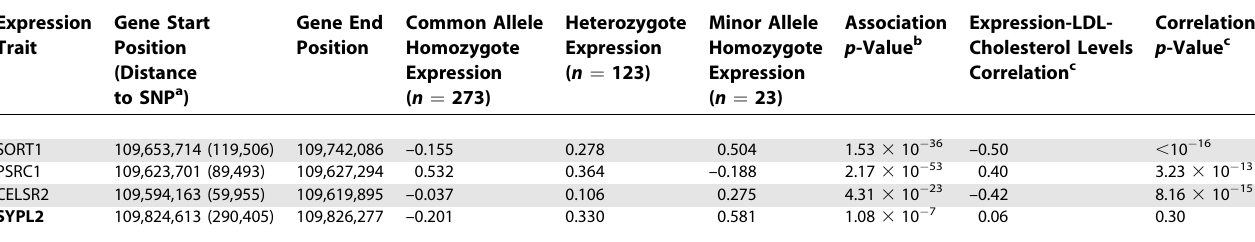
Table 4. Significant Associations Detected between Liver Expression Traits in the HLC and the CAD-Associated SNP, rs599839, on Chromosome